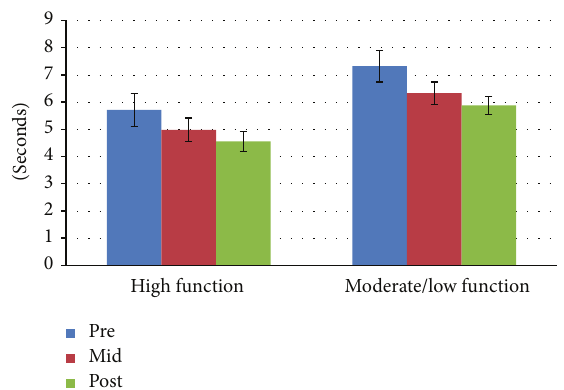
Figure 6: Eight-foot up-and-go test mean scores by group and